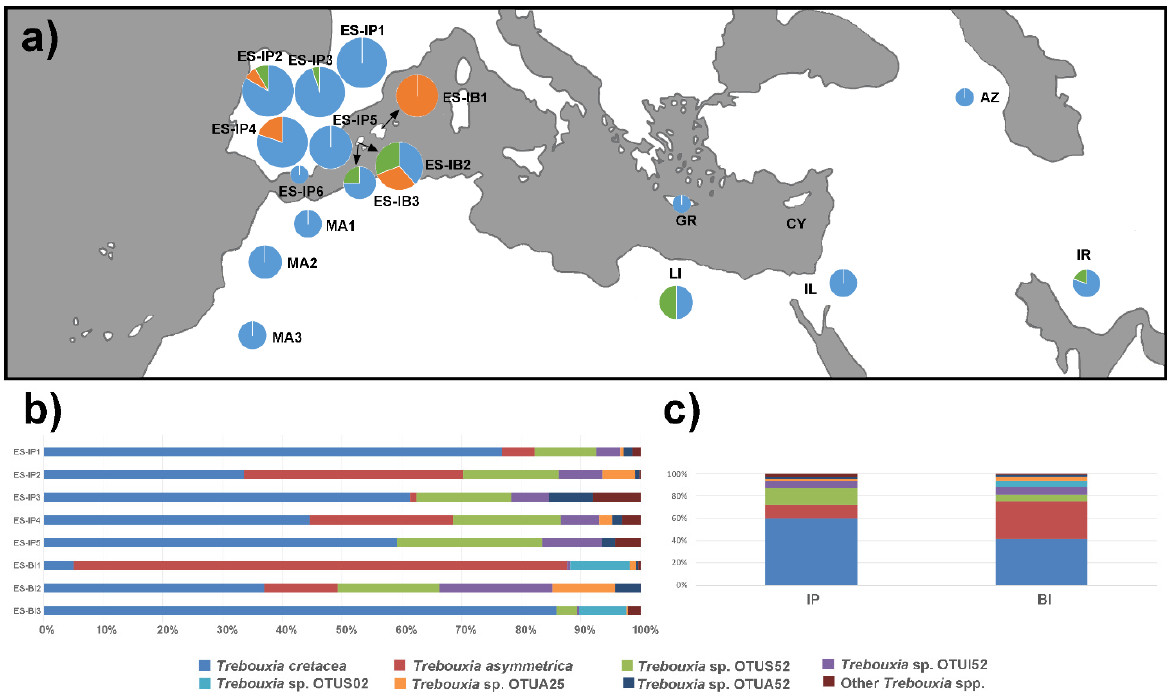
Figure 2. ( a ) Primary Trebouxia spp. detected by Sanger sequencing depicted in the localities included in this study (total sample number = 153); different Trebouxia spp. are coded with different colors. ( b ) Graphs of mean relative abundance of Trebouxia spp. for all the samples ( n = 60) found in each locality. ( c ) Graphs of mean relative abundance of Trebouxia spp. found in (IP) the Iberian Peninsula and (BI) Balearic Island. Trebouxia spp. under 60,000 reads are grouped as other Trebouxia spp. The color coding for each Trebouxia is shown at the bottom left-hand side of the figures.